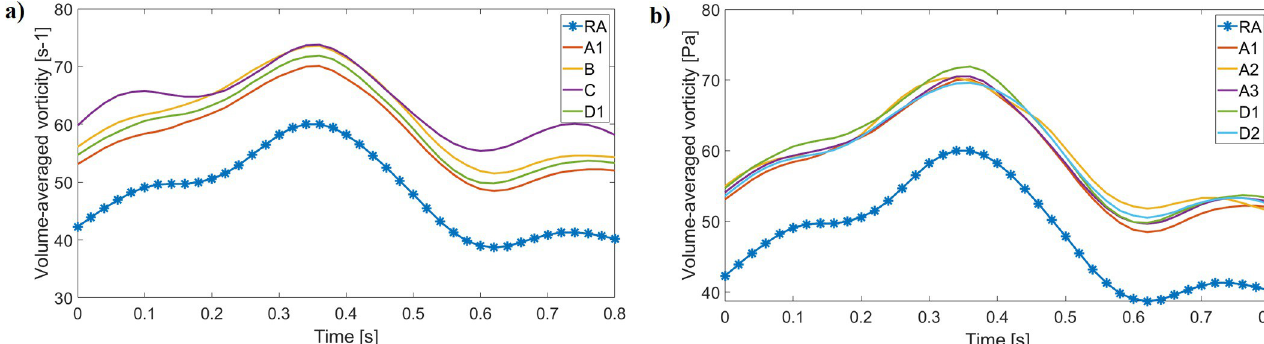
Fig 13. Volume-averaged vorticity profile through the cardiac cycle for the RA and all catheter models (generated with data from S12 File). (a) All designs are compared with the RA; (b) A and D tip placement changes do not greatly influence overall vorticity quantifications.